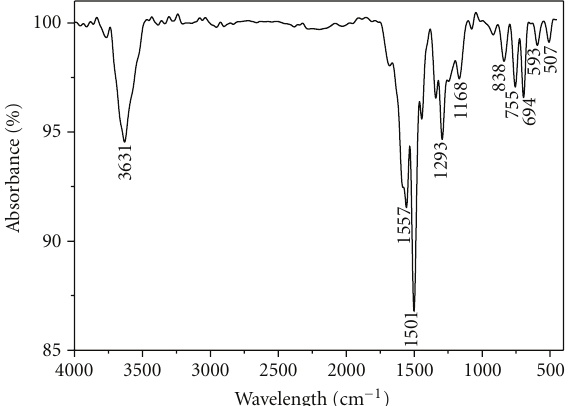
Figure 2: FT-IR spectra of the polymer (PANI-ES) obtained by the persulfate oxidation method (emeraldine black) at 0 ◦